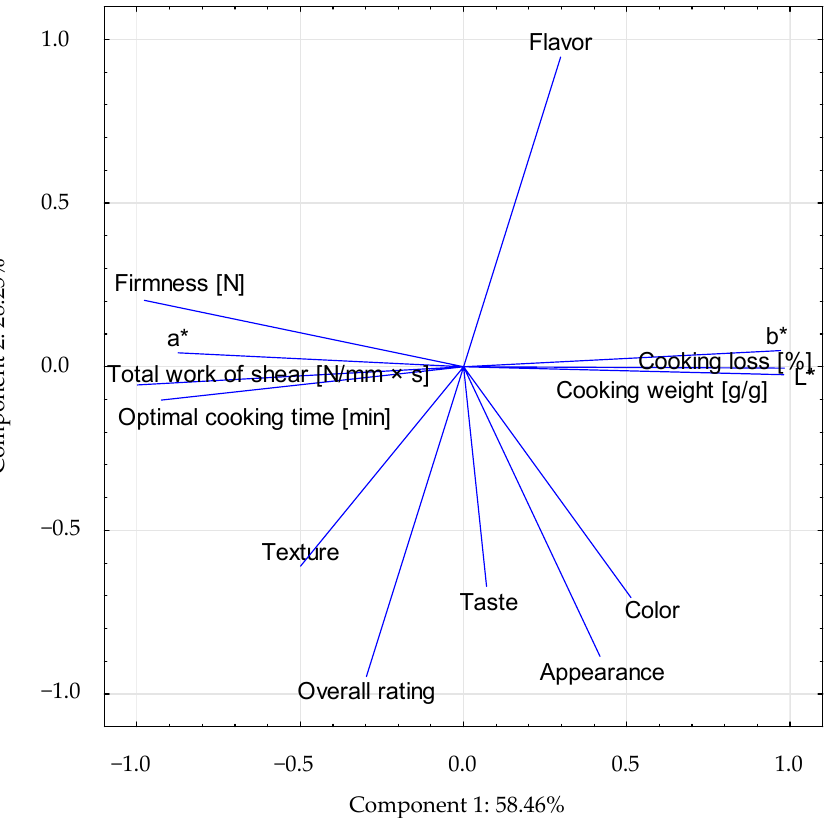
Figure 2. Projection of the variables on the component plane (1 × 2). L*: lightness; a*: redness; b*: